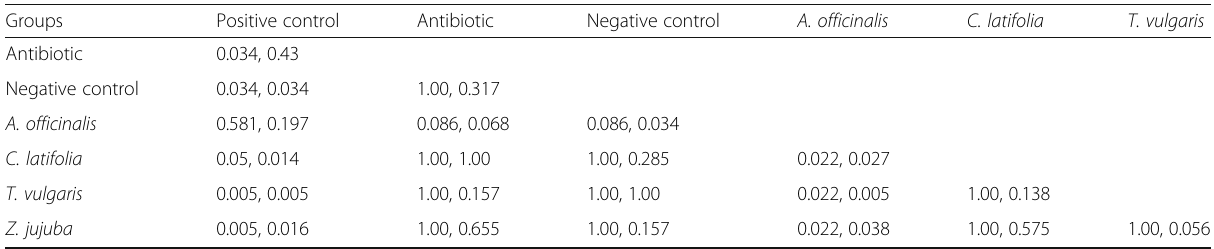
Gross lession score was compared using Kruskle-Wallis test. Comparison among groups was performed using Mann Whitney U test. P ≤ 0.05 was considered signifi- cant. Data is presented in terms of P -values of lungs and hearts